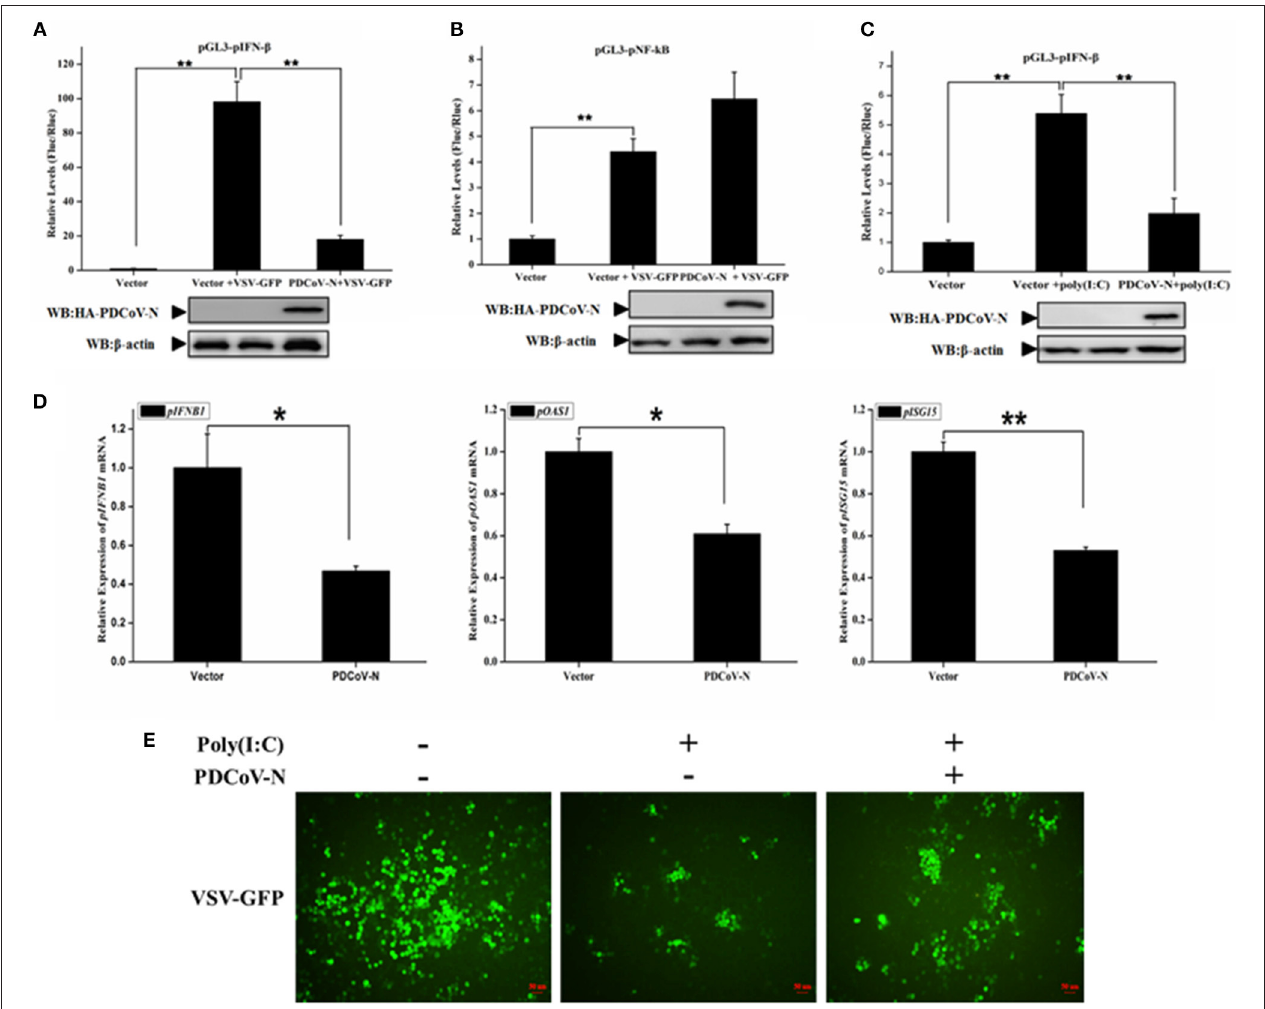
FIGURE 1 | PDCoV N protein inhibited porcine IFN- β and ISGs expression. (A–C) PK-15 cells cultured in 24-well plates were transfected with porcine IFN- β -Luc (pGL3-pIFN- β ) or porcine NF- κ B-Luc (pGL3-pNF- κ B) plasmid and pRL-TK plasmid with PDCoV N expression plasmid (pcDNA3.1-HA-PDCoV-N). At 18h after transfection, cells were treated or untreated with VSV-GFP or Poly(I:C) (LMW). The cells were then subjected to dual-luciferase assays at 16h post-treatment. The relative firefly luciferase activity was relative to that of an empty vector control. The Renilla reniformis luciferase activity was used to normalize. The expression of PDCoV N protein was detected by western blot with HA antibody. β -actin was detected as the loading control. (D,E) PK-15 cells cultured in 12-well plates were transfected with pcDNA3.1-HA-PDCoV-N or empty plasmid for 24h, and then transfected with Poly(I:C) (LMW). (D) After 16h post transfection, the cells were lysed by TRZOL to extract the total RNA. The qRT-PCR was used to detect the relative expression of porcine ISGs mRNA. (E) At 12h post transfection, the VSV-GFP (MOI = 0.1) infected the PK-15 cells for another 16h. The GFP was detected by fluorescence microscope. * p < 0.05; ** p <